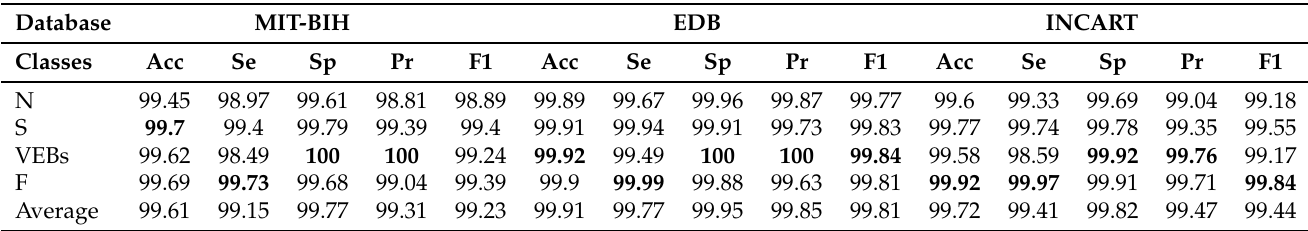
Table 5. The performance of the MPA-GBDT classifier on all the databases’ classes.